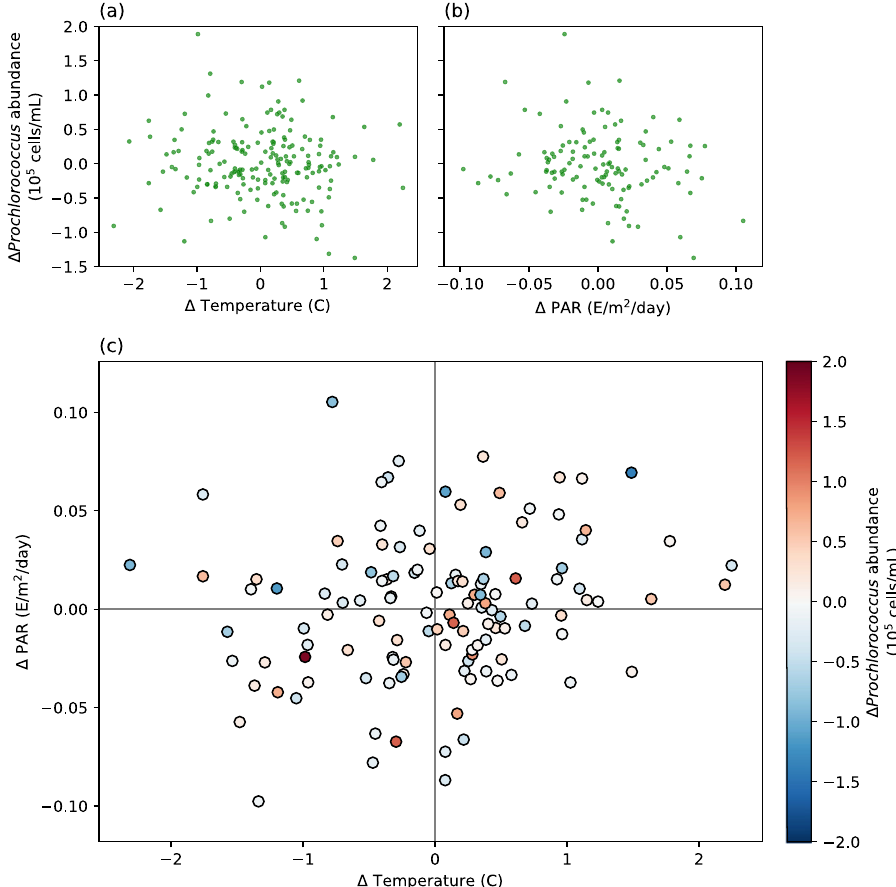
Fig. 3|Temporal fl uctuationsatStationALOHAdonotcorrelatestronglywith lightandtemperature. Monthtomonthchangesin Prochlorococcus populationin the upper 50 meters vs changes in temperature ( a ) and Photosynthetically Active